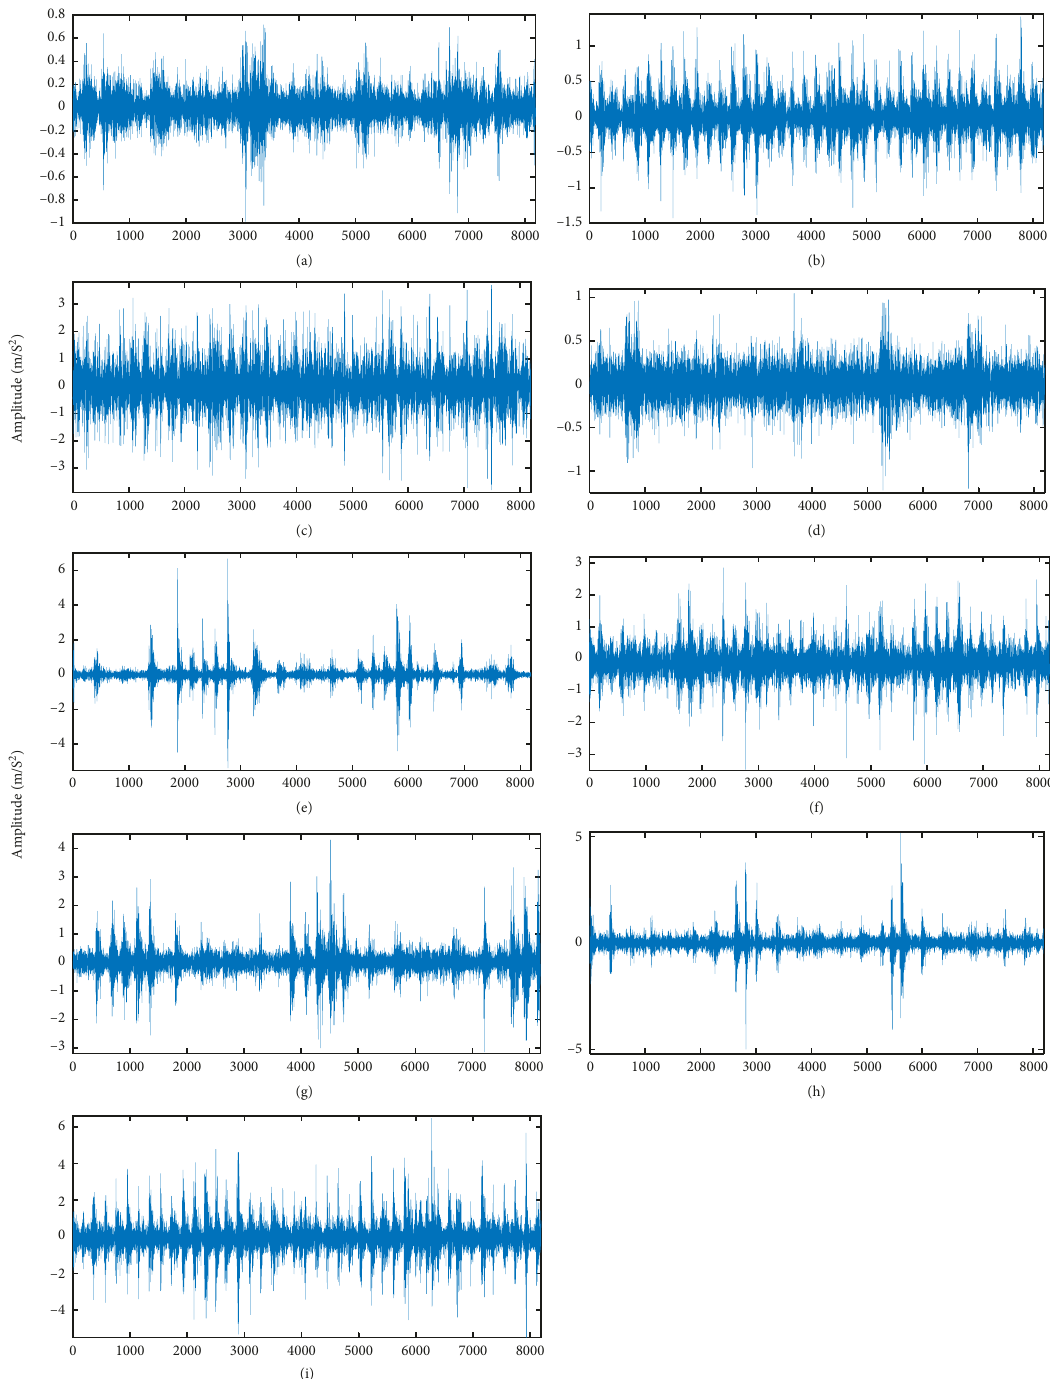
Figure 8: The collected vibration signals of the nine